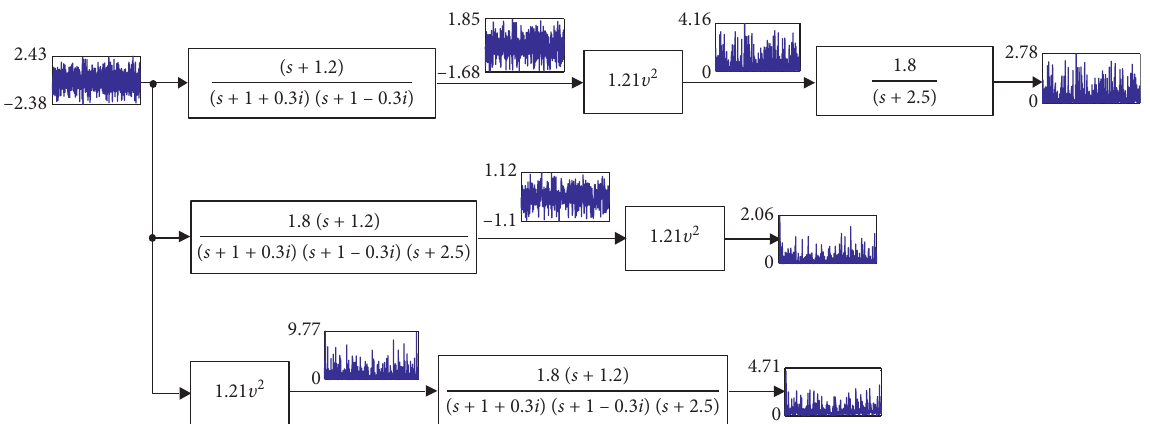
Figure 1: Example of search space limits for static nonlinearity in Wiener, Hammerstein, and Wiener–Hammerstein models when they are excited with a Gaussian